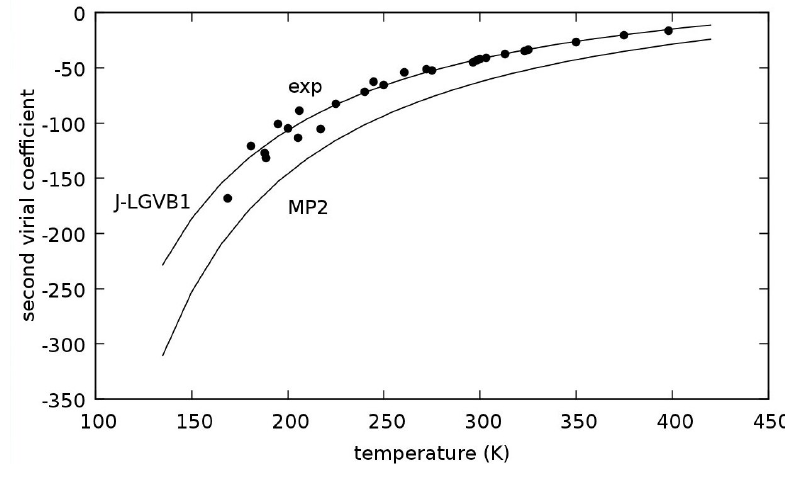
Figure 5. Second virial coefficient (cm 3 /mol) of methane as a function of temperature. Comparison between calculated (this work, solid line, and experimental values (circle,